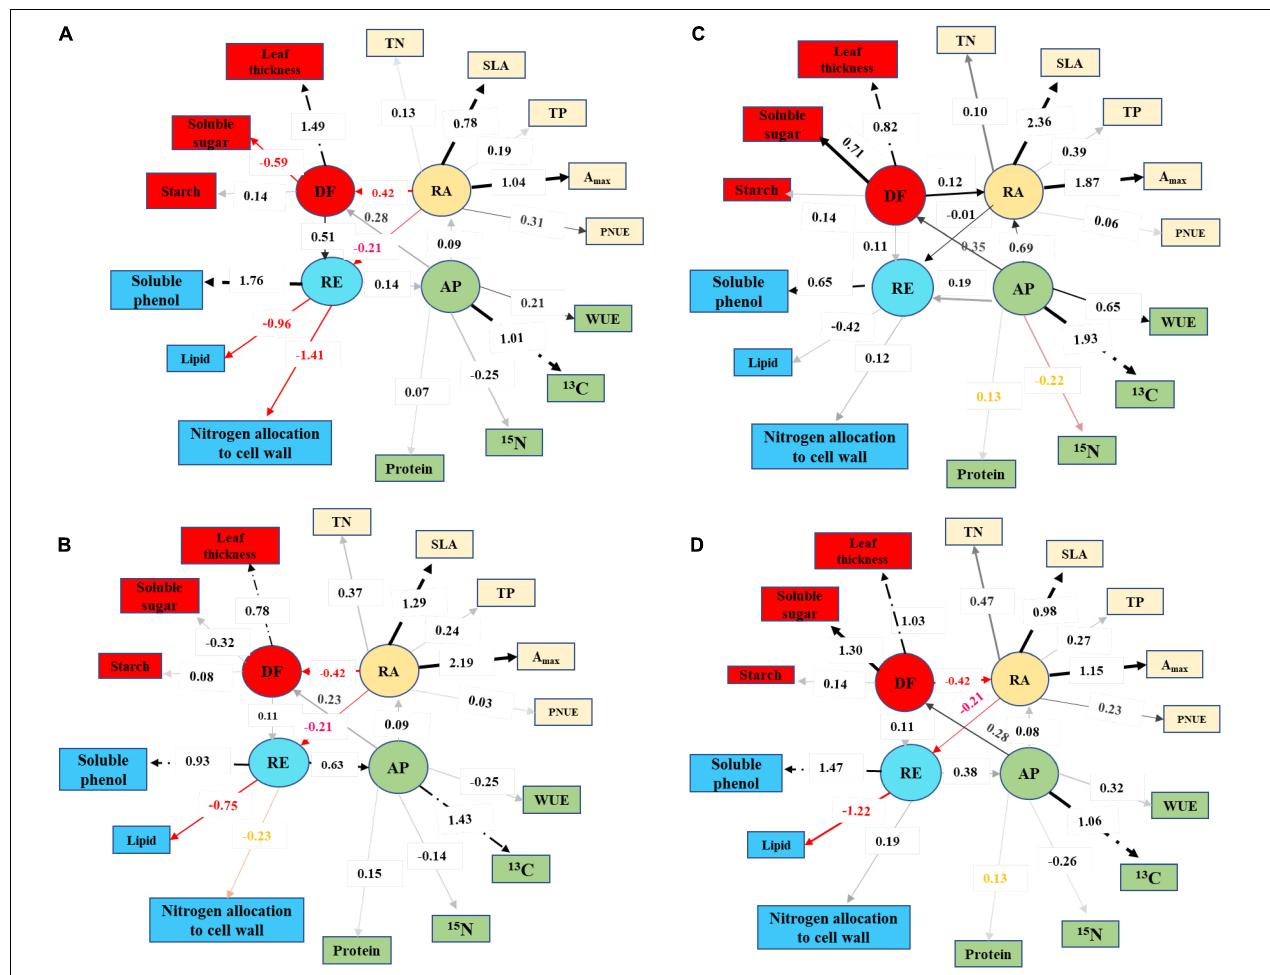
FIGURE 6 | Confirmatory factor analysis on the trait loading values per integrated functions (RA, resource acquisition; AP, adaptation; DF, defense; RE, resistance) and relationships between the functions for canopy and understory plants in urban and suburban habitat: (A) canopy plants in urban area; (B) canopy plants in suburban areas; (C) understory plants in urban area; and (D) understory plants in suburban areas. The numbers in the line between the latent variable and its observed variables denoted loading values, and the numbers in the line between four latent variables showed regression